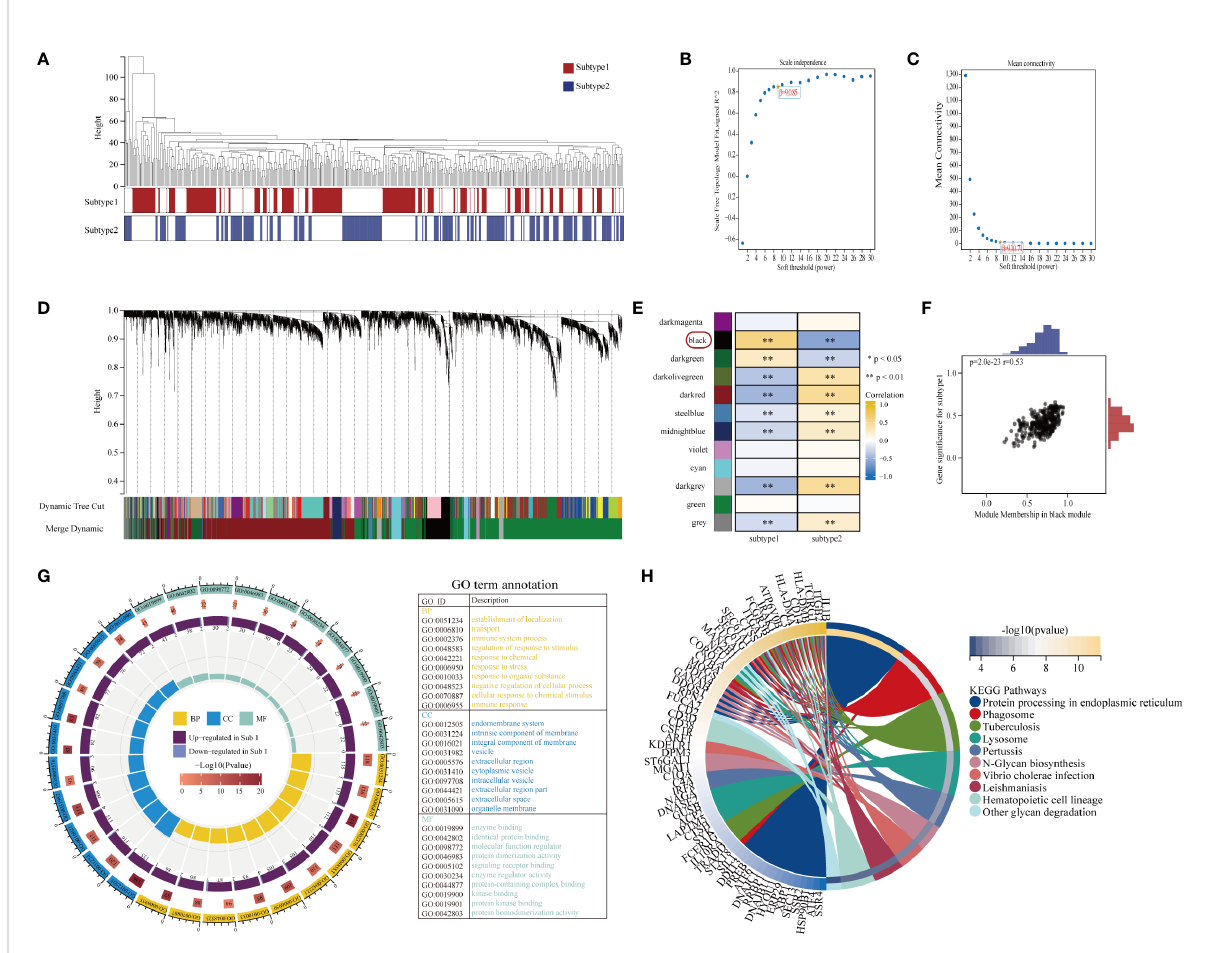
FIGURE 9 Construction and module analysis of weighted gene co-expression network analysis (WGCNA). (A) Sample dendrogram and trait heatmap. (B, C) The selection of the smallest soft threshold. (D) Gene dendrogram obtained by average linkage hierarchical clustering. The color row underneath the dendrogram showed the module assignment determined by the Dynamic Tree Cut. (E) Heatmap of the correlation between module eigengenes and the aging modi fi cation patterns. (F) A scatterplot of gene signi fi cance (GS) for subtype-1 vs module membership (MM) in the black module. GS and MM exhibited a very signi fi cant correlation, implying that hub genes of the black module also tend to be highly correlated with subtype-1. (G) Gene Ontology enrichment analysis of aging phenotype-related genes, the outermost ring represented the name of pathways. The second outer ring represented the number of genes in pathways, and the heights of the columns in the inner ring indicated the value of GeneRatio. (H) Chord plot depicting the relationship between genes and KEGG signaling